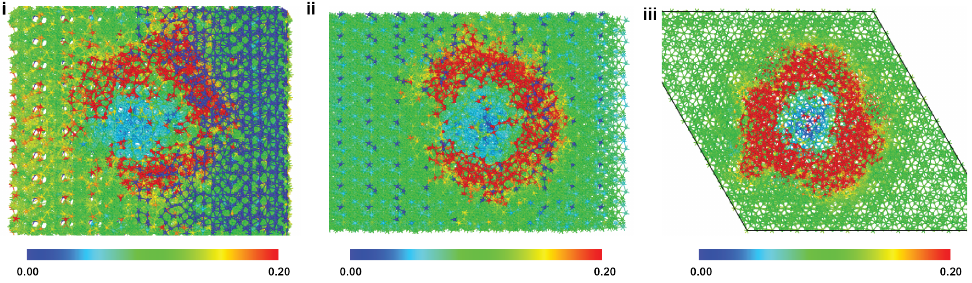
Figure 7. Atomic snapshots of HAP models containing 30 Å pores at the inception of compressive failure for X ( i ), Y ( ii ), and Z ( iii ) loading. Atoms are colored according to the atomic shear strain. X and Y loading images are viewed in the X-Y plane, whereas the Z loading image is in the Y-Z